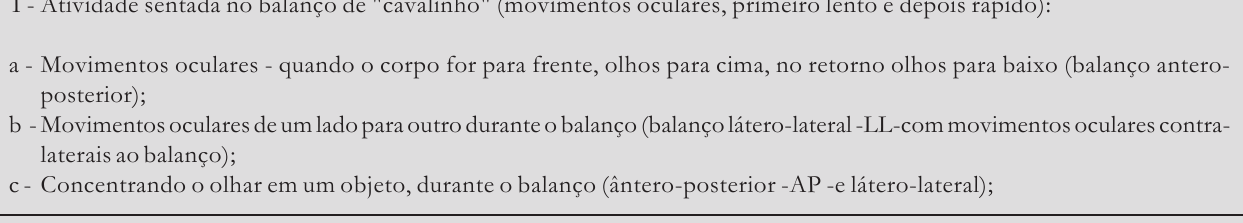
Tabela 1 - Protocolo de tratamento para reabilitação